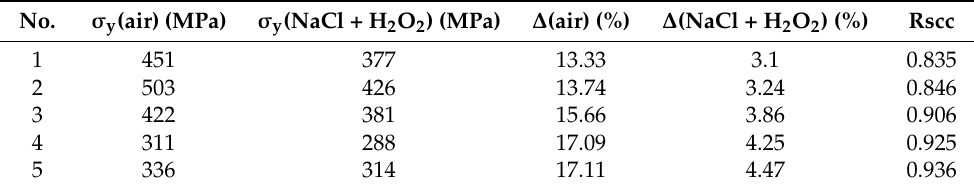
Table 3. The results of SSRT tests (strain rate 8.34 × 10 − 7 s − 1